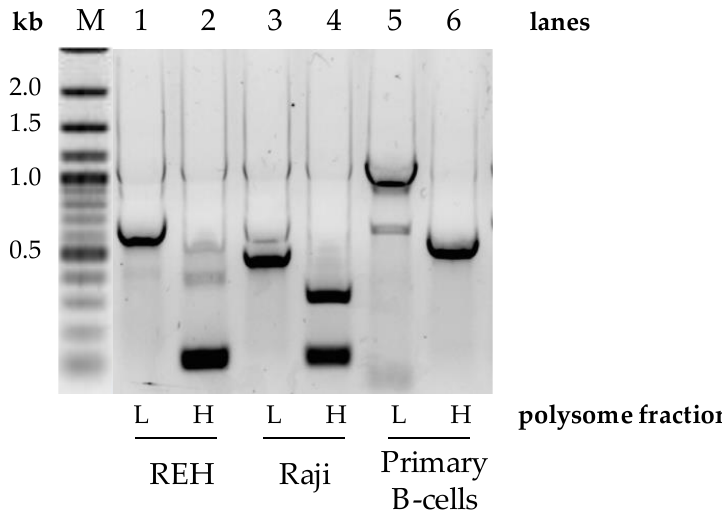
Figure 3. Pax-5 3 (cid:48) UTR profiling from polysomal fractionation. The mRNA from polysomal fractions of B-cell populations was extracted, amplified by RT-PCR, and sequenced. Polysomal light (L) fractions represent low translational activities (none or few ribosomes attached to the mRNA), whereas heavy (H) fractions represent active mRNA translational complexes. PCR primers were designed to flank the excised spliced regions of the Pax-5 3 (cid:48) UTR and be compared between B-cell lines (REH and Raji) and primary CD19+ B-lymphocytes from healthy donor PBMCs. “M” indicates the reference molecular weight marker with corresponding nucleotide length kilobases